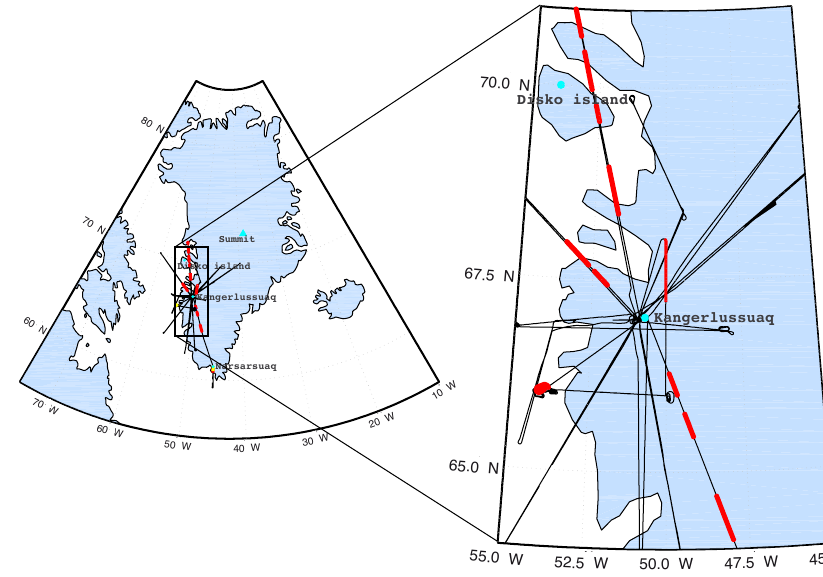
Fig. 1. ATR-42 flight trajectories during the POLARCAT-France summer campaign. Flight segments related to air mass origins from the North American continent studied in this paper are highlighted in red for Canadian forest fires and in yellow for anthropogenic air masses. The anthropogenic air mass was sampled in southern Greenland (Narsassuaq), thus, the sampling period is not represented in the